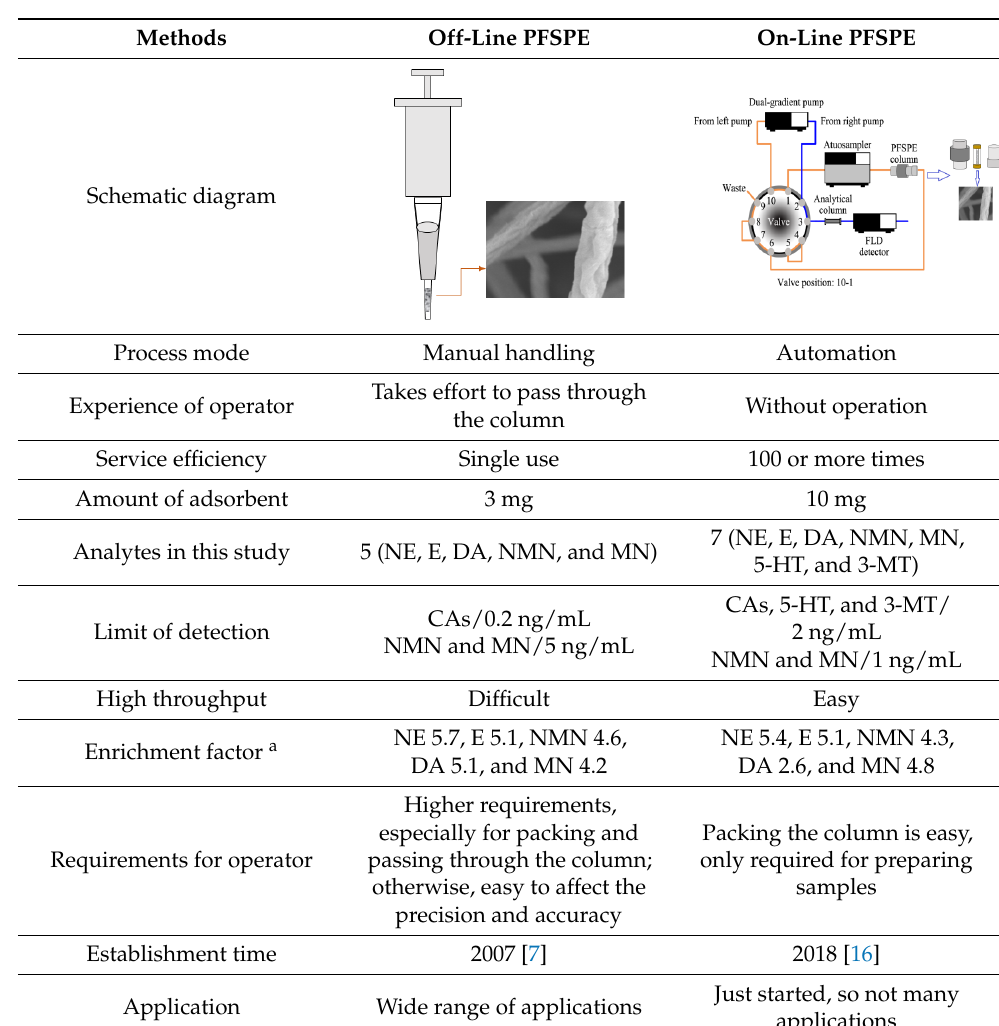
Table 4. Comparison of the off-line and on-line PFSPE–HPLC methods.